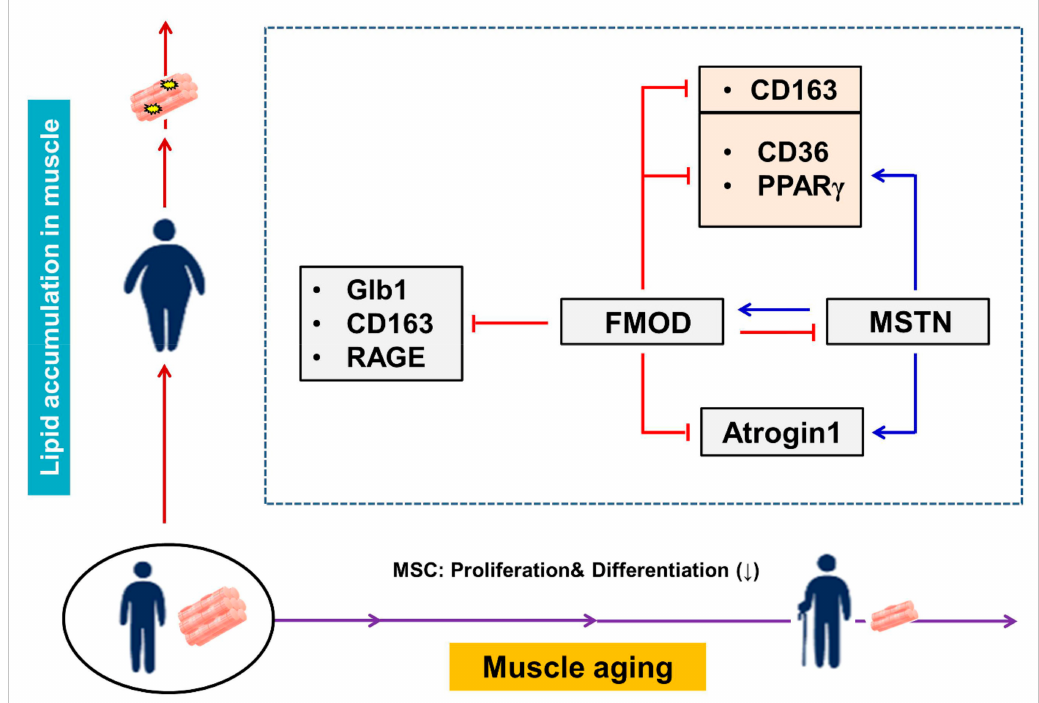
Figure 7. Summary of proposed relationships between the expressions of FMOD and MSTN during aging. The inverse relationship between MSTN and FMOD. FMOD inhibits Glb1, CD163, RAGE, and Atrogin1. MSTN increases Atrogin1 expression. FMOD negatively regulates the expressions of CD36, PPAR γ , and